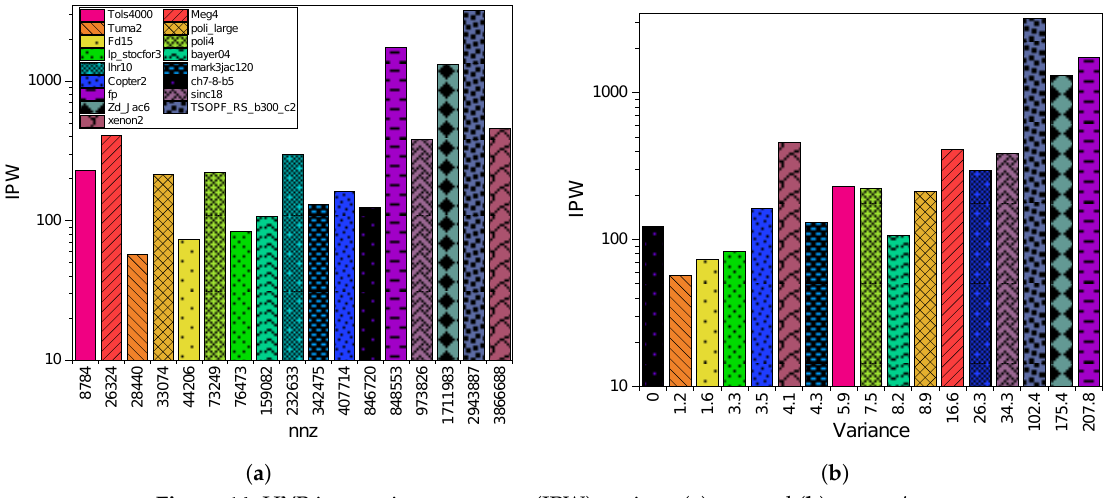
Figure 14. HYB instructions per warp (IPW) against: ( a ) nnz and ( b ) npr variance